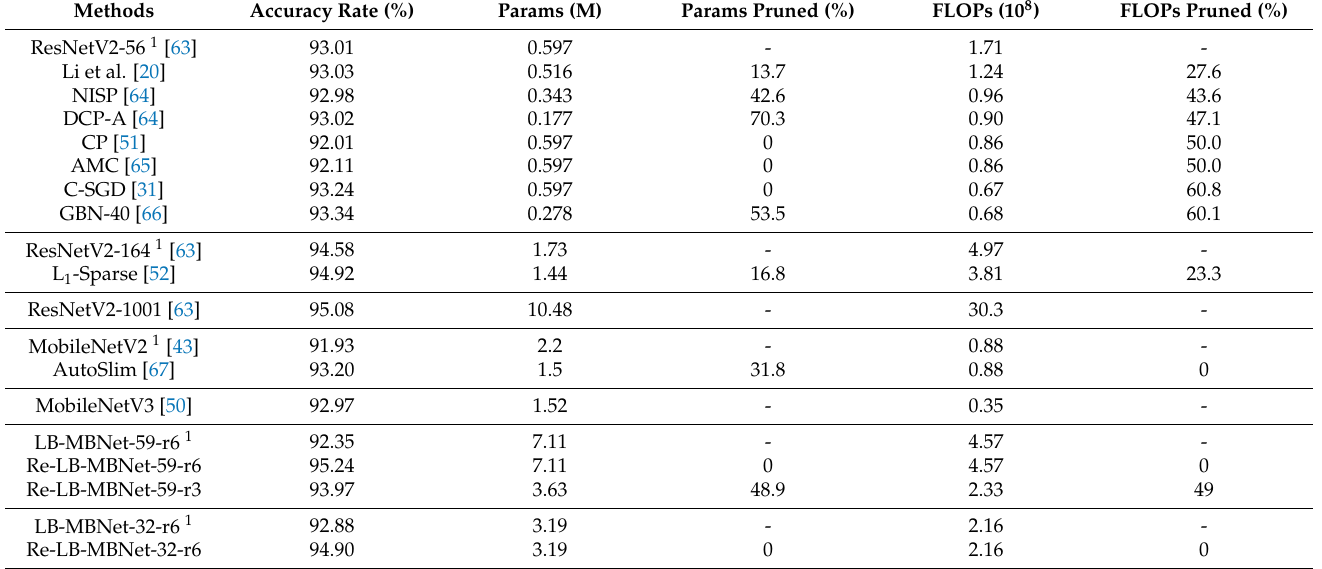
Table 4. Comparison results with the state-of-the-art methods on the CIFAR-10 database. FLOPS, floating-point operations per